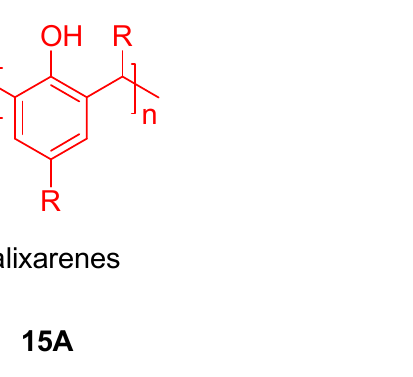
Figure 16. Schematic representation of calix[n]arene ( 15A ) and calix[4]arene ( 15B